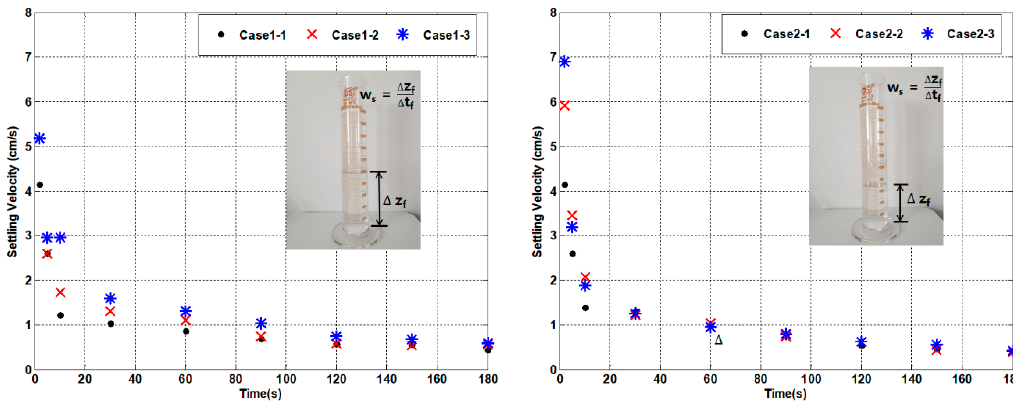
Figure 3. Typical time-specific settling velocity curves.